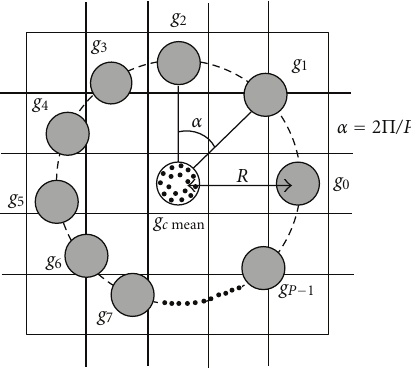
Figure 2: The central pixel g c and its P circularly symmetric neighbor with radius R